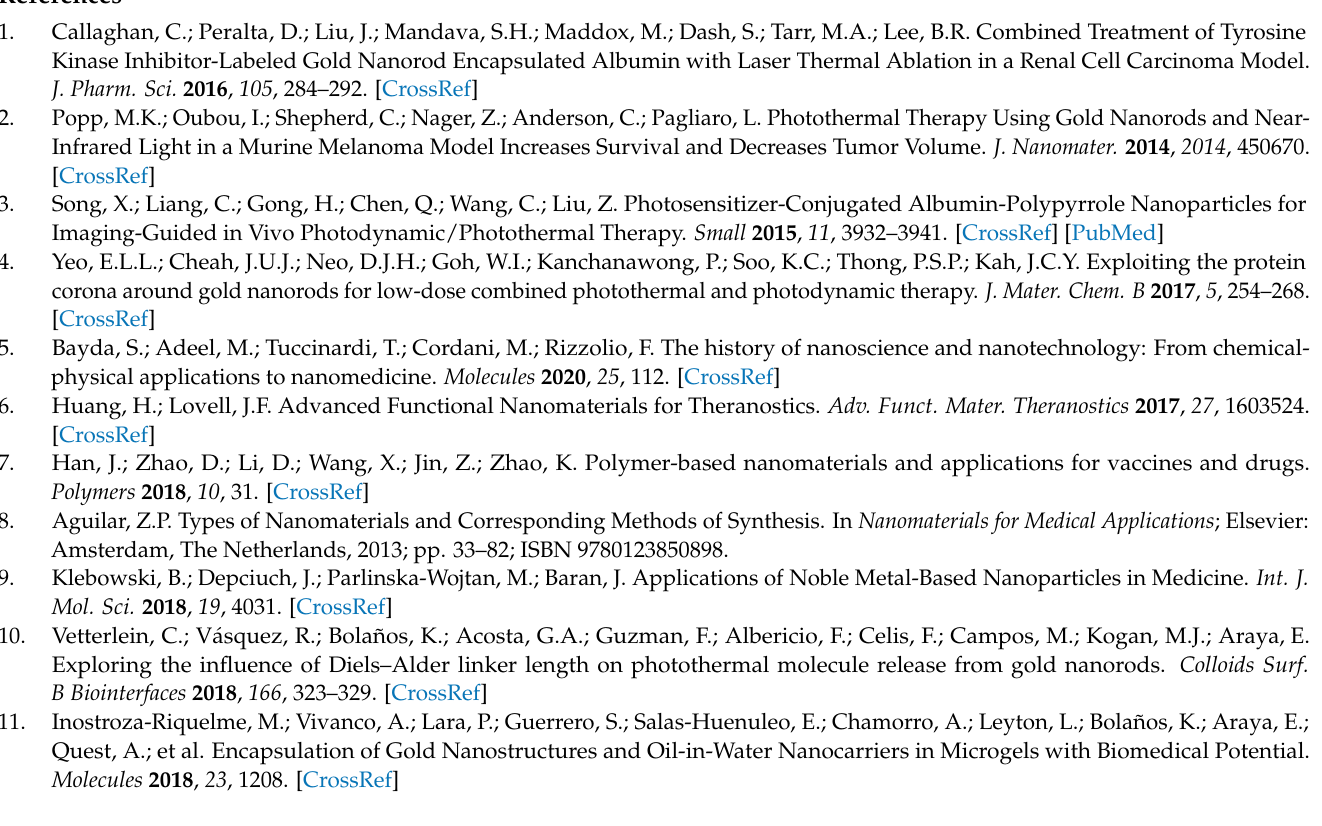
statistics of at least 50 AuNRs, Figure S4: Microscopy characterization of AuNPrs: a, b. representative TEM images, scale 200 nm, c. Edge length (nm) frequency distribution (length/width), statistics of at least 50 AuNPrs, Figure S5: Characterization of BSA-r 8 capped AuNPs after 24 h, DLS and Zeta potential, Figure S6: Flow cytometry of Hela cells incubated by 24 h with: a. water, b. AuNR- BSA-r 8 1 nM in AuNRs, c. AuNPr-BSA-r 8 1 nM AuNPrs, Figure S7: TEM images of HeLa cells after treatment by AuNR-BSA-r 8 incubated by 1 h, Figure S8: TEM images of HeLa cells after treatment by AuNPr-BSA-r 8 incubated by 1 h, Table S1: Amino acid analysis of BSA-r8 after acid digestion, using Υ -aminobutiric acid as standard